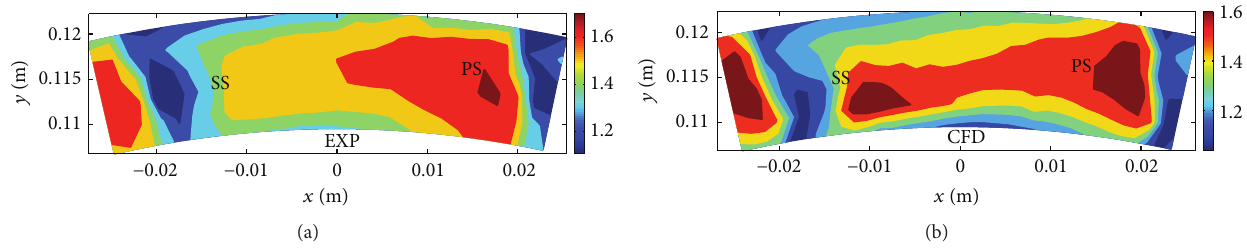
Figure 12: Comparison of measured (a) versus predicted (b) nondimensional stagnation pressure contours downstream of the mixed flow stator over 1.18-blade pitch at point 9 in Figure 7.